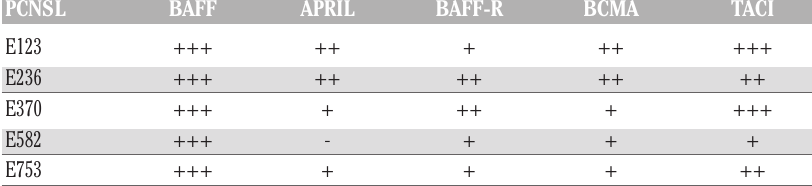
Table 1. Semi-quantitative assessment of expression of the BAFF/APRIL system in the dif- ferent tumor specimens.